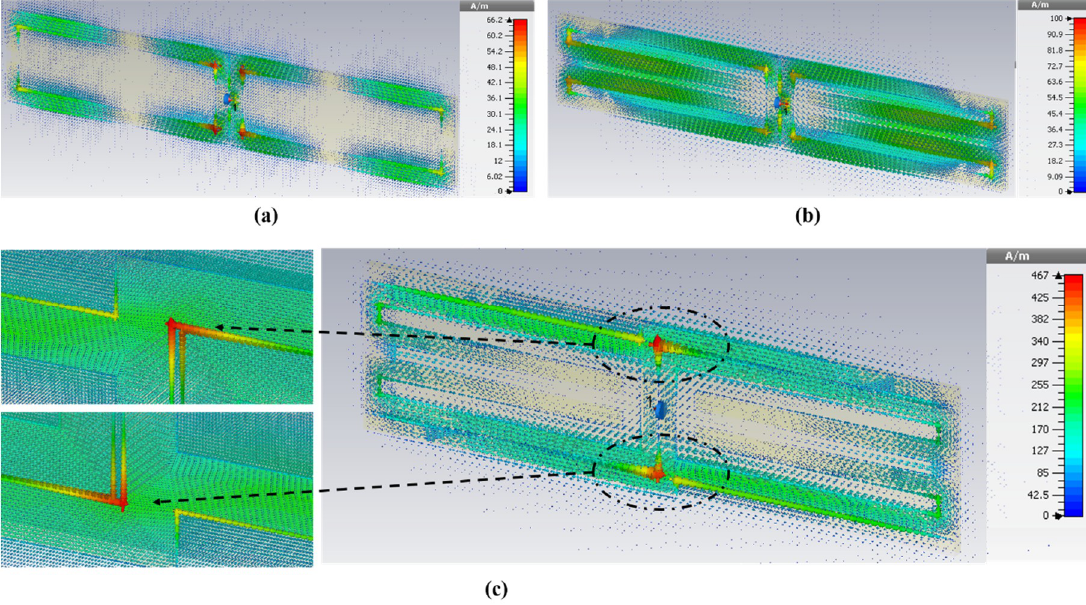
Figure 3. Tag antenna’s surface current distribution at the resonance frequency for design procedure; ( a ) first stage, ( b ) second stage and ( c ) final ( a ) first stage, ( b ) second stage and ( c ) final stage.